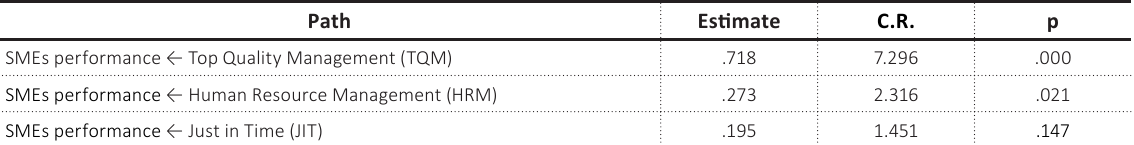
Table 4. Path analysis for the constructs of the study